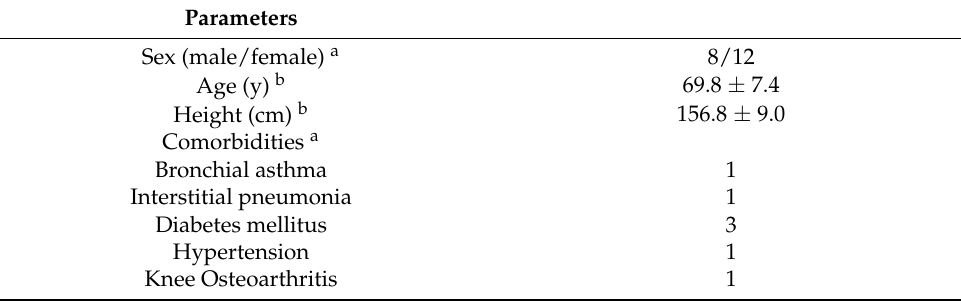
Table 1. Characteristics of the study